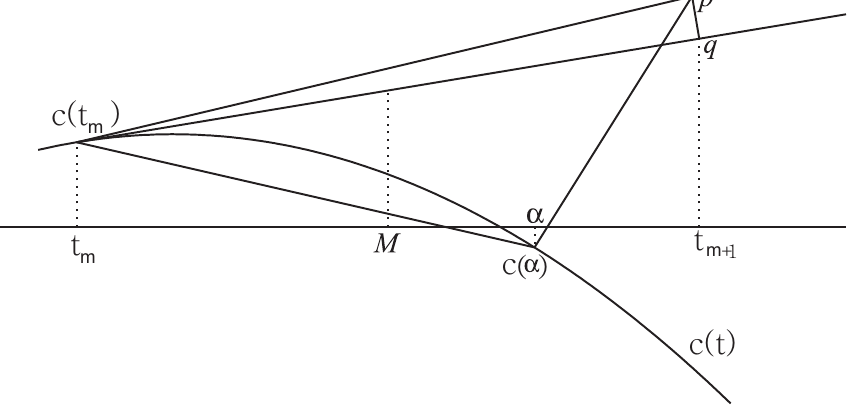
Figure 1. Geometric illustration for convergence